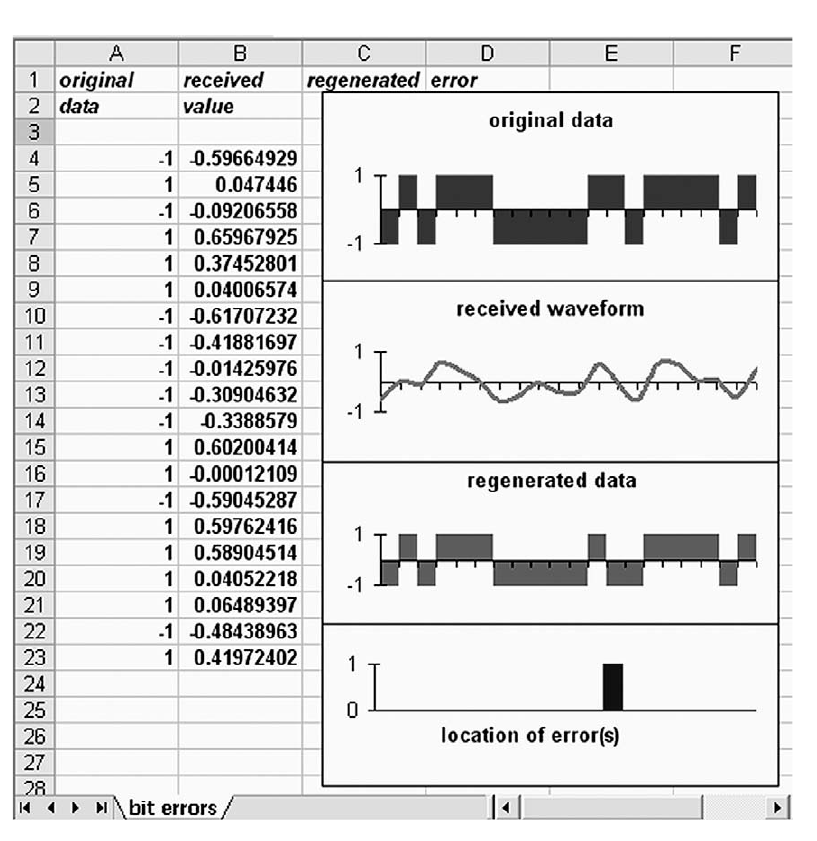
Figure 1. How a digital signal can be regenerated with or without